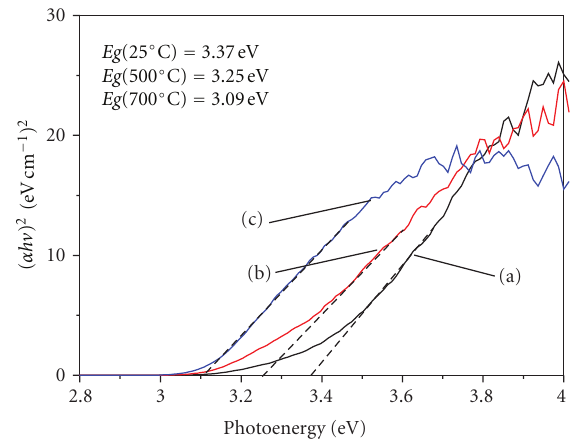
Figure 4: Plots of ( hvα ) 2 versus photon energy for the P25 powders before (a) and after calcination at 500 (b), and 700 ◦ C (c) for 4h.